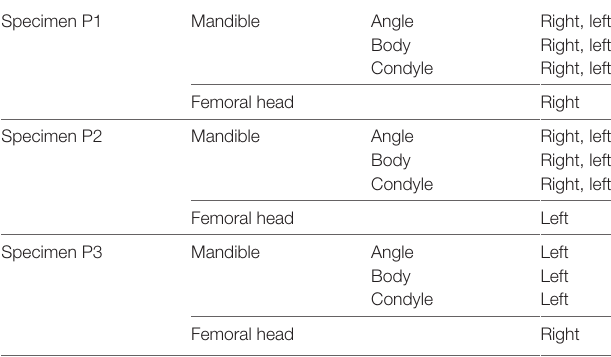
TaBle 1 | List of examined parts from each of the